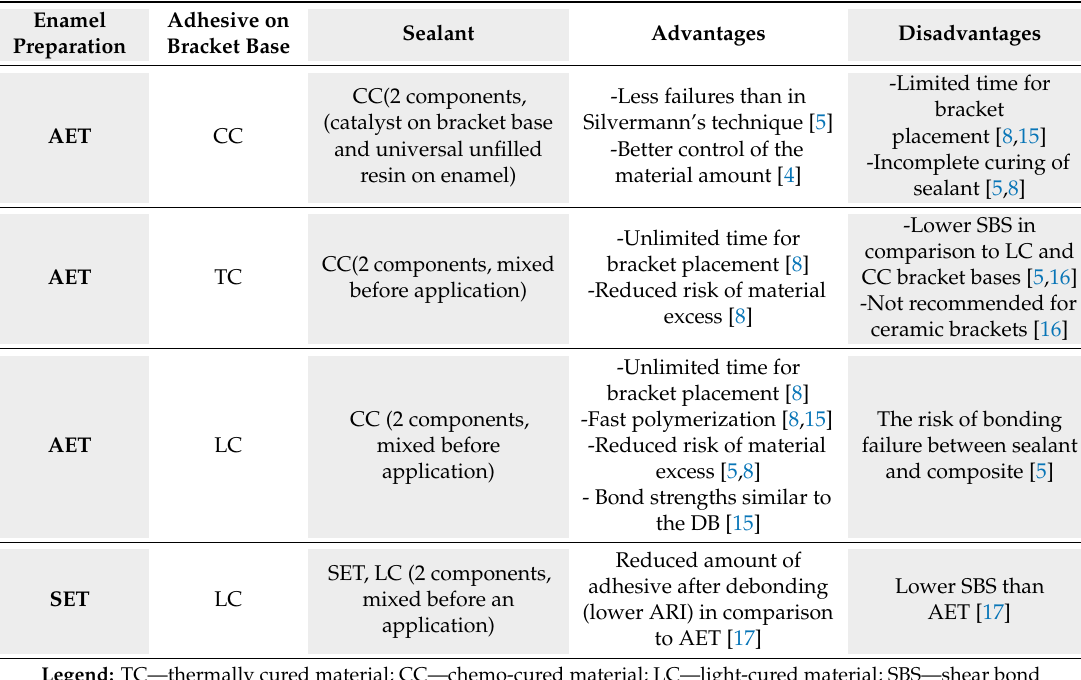
Table 2. Advantages and disadvantages of various types of materials used in the indirect bonding technique